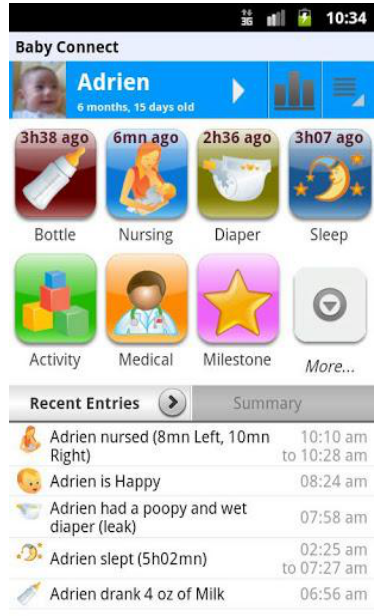
Figure 2. Screenshot from Baby Connect app indicating various facts about baby Adrien, including his age, when he last nursed, the status of his last nappy, the length of his last sleep and his mood: ―Adrien is Happy‖. Any of these features could be posted on Facebook or sent to other synchronised devices. Source: Seacloud Software (with permission to use